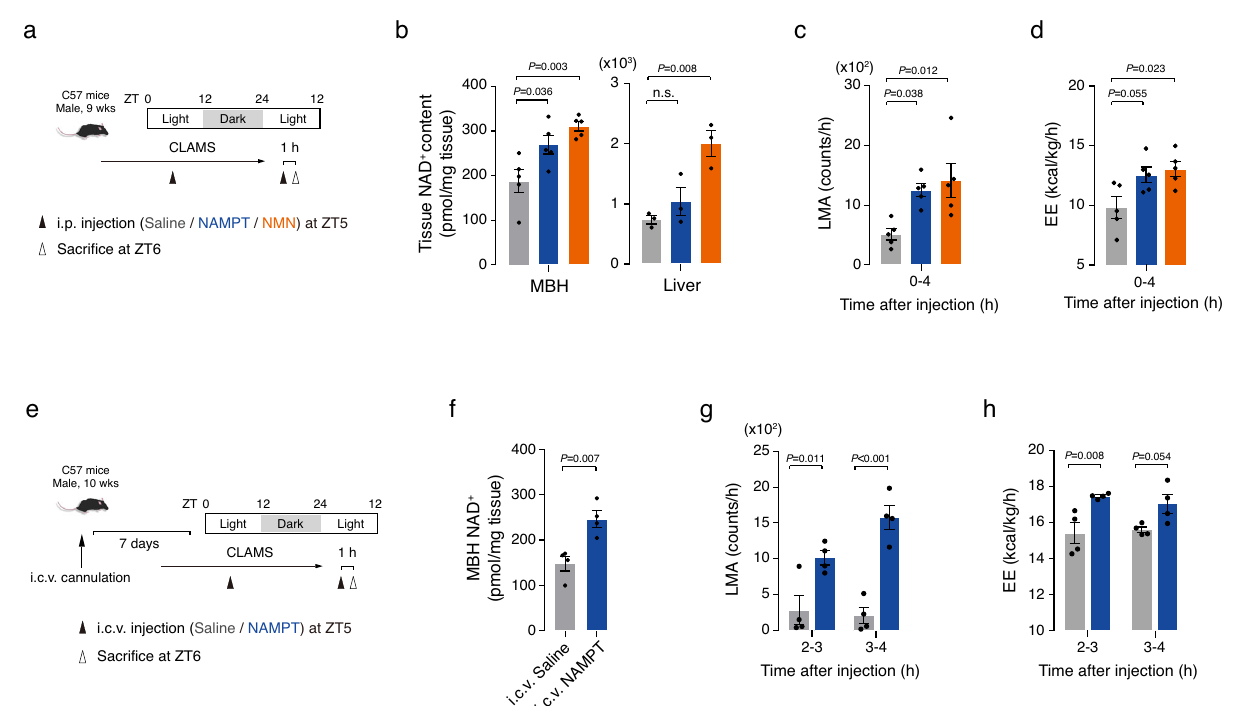
Fig. 3 | Arti fi cial elevation of systemic eNAMPT activity increases locomotor activityandenergyexpenditure.a Schematicdiagramoftheintraperitoneal(i.p.) NAMPT/NMN injectionstudy.ZT:zeitgebertime. b Themediobasalhypothalamus (MBH) and liver NAD + levels at ZT6 1h after i.p. administration of NAMPT (0.3mg/kg) and NMN (120mg/kg) (MBH, n =5;Liver, n =3mice).One-way ANOVA followed by Fisher ’ s LSDtest.n.s.: not signi fi cant. c , d Effects of i.p.administration ofNAMPTandNMNondaytimelocomotoractivity(LMA)andenergyexpenditure